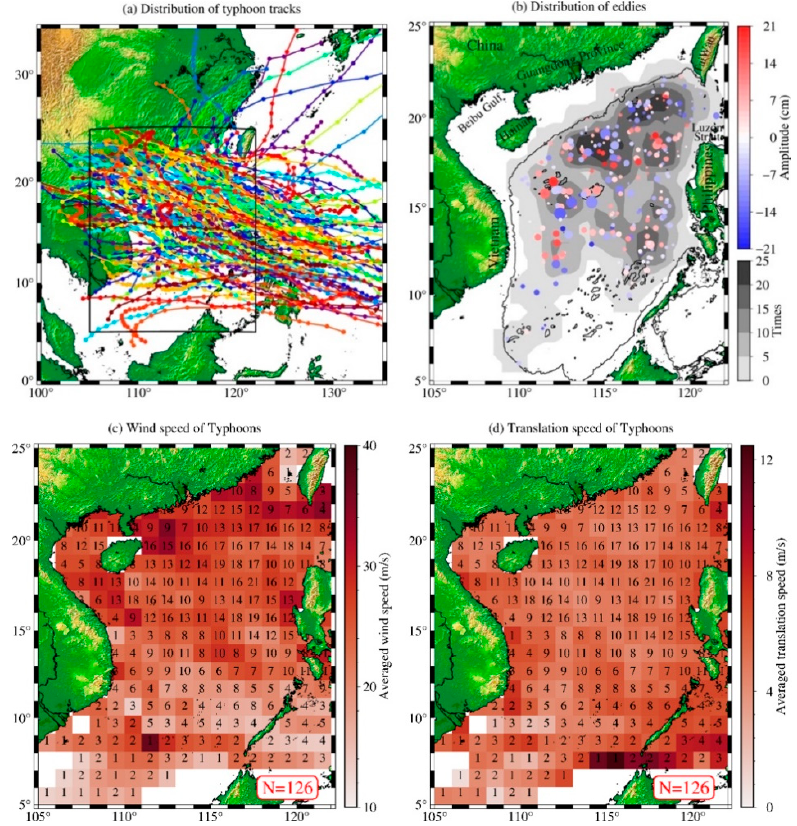
Figure 1. The distributions of typhoon tracks ( a ) and eddies ( b ) with different polarities under typhoons between 2003 and 2017 and the frequency with which typhoons passed over the South China Sea (SCS). In ( a ), the colored lines show the tracks of typhoons. In ( b ), the colored dots show the locations of eddies that are the closest to the typhoon tracks, and the colors represent sea level anomalies with positive values for anticyclonic eddies (AEs) and negative values for cyclonic eddies (CEs). The black contour represents the 200-m isobath, and grayscale represents the number of co-occurrences of eddies and typhoons. The distribution of average ( c ) wind speed and ( d ) translation speed over a specific mesh of 1° × 1° in the South China Sea from 2003 to 2017 with color shading. The numbers indicate the frequency of typhoon occurrence, while blank means no existence of typhoons during the period. The land is covered by terrain color maps in all panels.